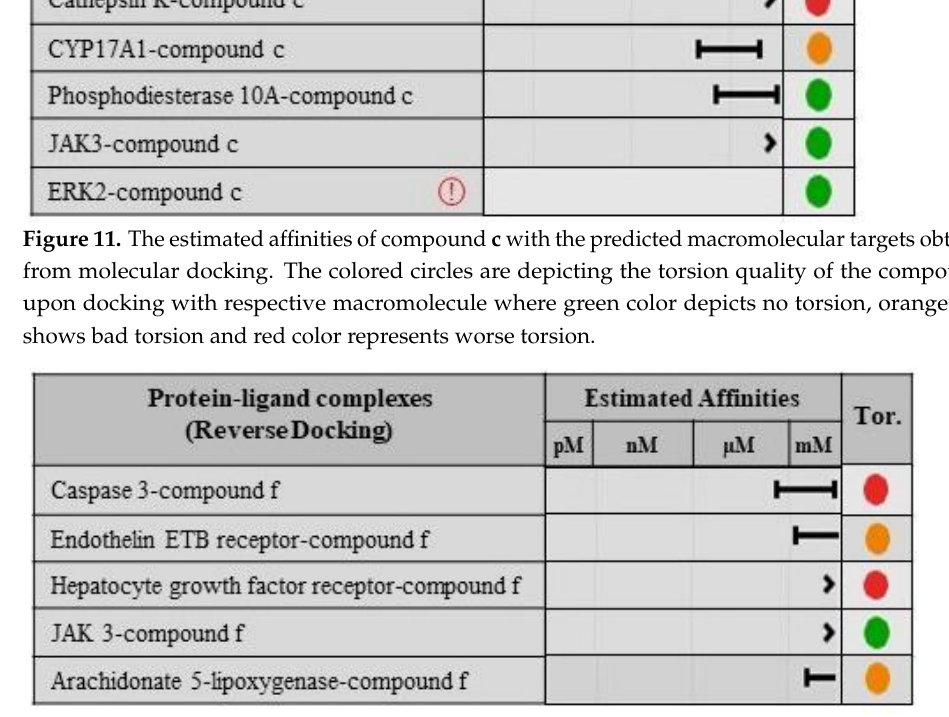
Figure 12. The estimated affinities of compound f with the predicted macromolecular targets ob- tained from molecular docking. The compound f torsion quality upon docking with respective mac- romolecule is depicted by colored circles, where green indicates no torsion, orange indicates bad torsion, and red represents worse torsion.